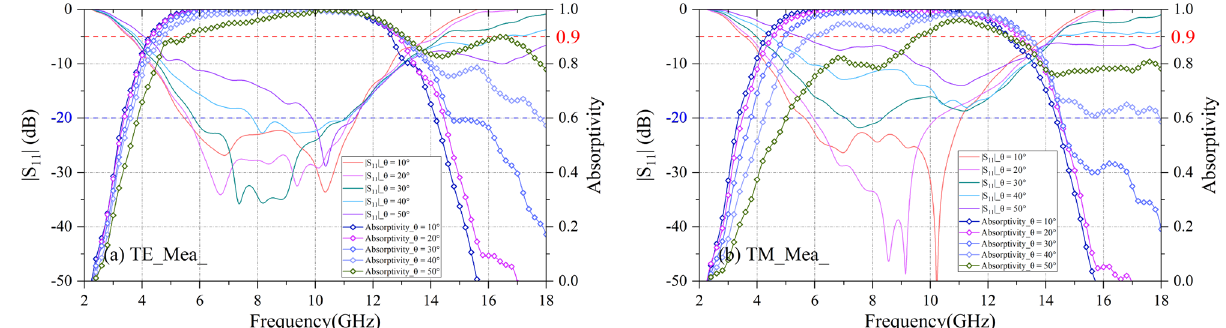
Figure 10. Measurement results of reflection coefficients and absorptivity under the different oblique incidences. ( a ) TE-polarization and ( b ) TM-polarization.